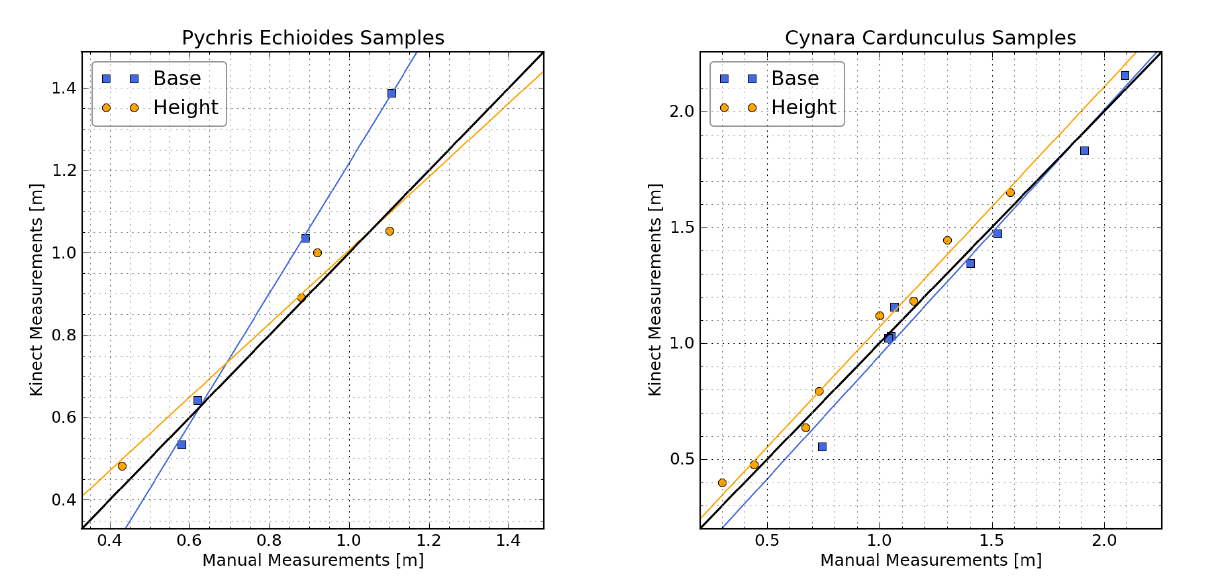
Figure 4. Direct comparison of manual and Kinect measurements of plant basal diameter (“Base”; the average of x and y measurements) and plant height (“Height”). Solid lines represent least squares linear fits.